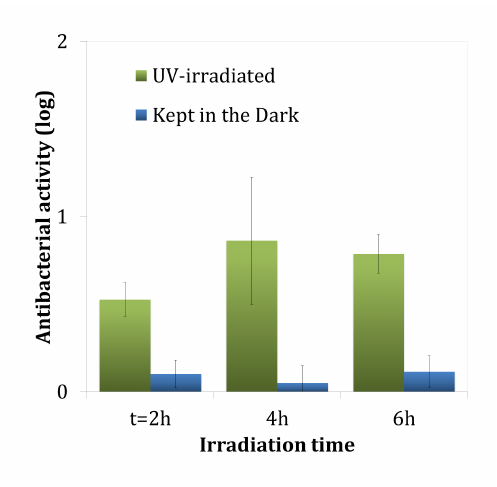
Figure 2. Antibacterial activity on E. coli of TiO 2 -coating (glass slides), after 2 h, 4 h, and 6 h of contact. Mean ± s.e., n =